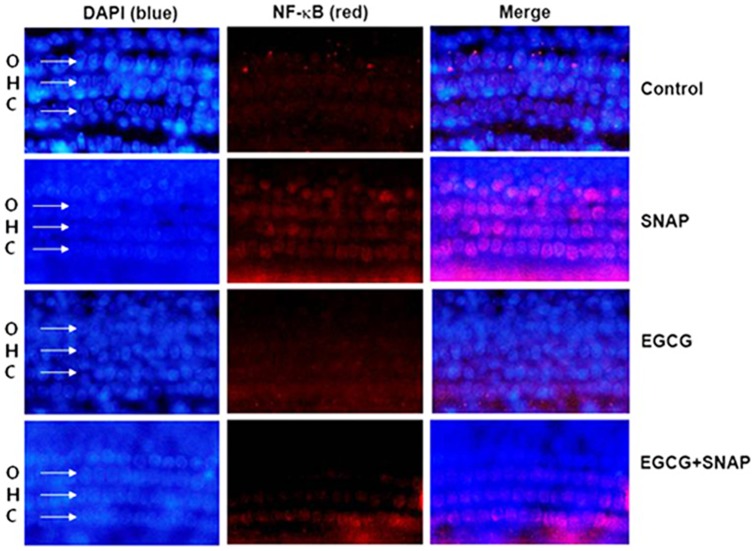
Effects of EGCG on NF-κB activation in the organ of Corti.Organ of Corti explants isolated from rats were pretreated with 50 μM EGCG for 2 h, followed by treatment with 500 μM SNAP for 4 h. Explants were fixed, stained with TRITC-conjugated phalloidin (NF-κB, red) and DAPI (nuclear, blue), and examined under an Olympus microscope (magnification, 100×).